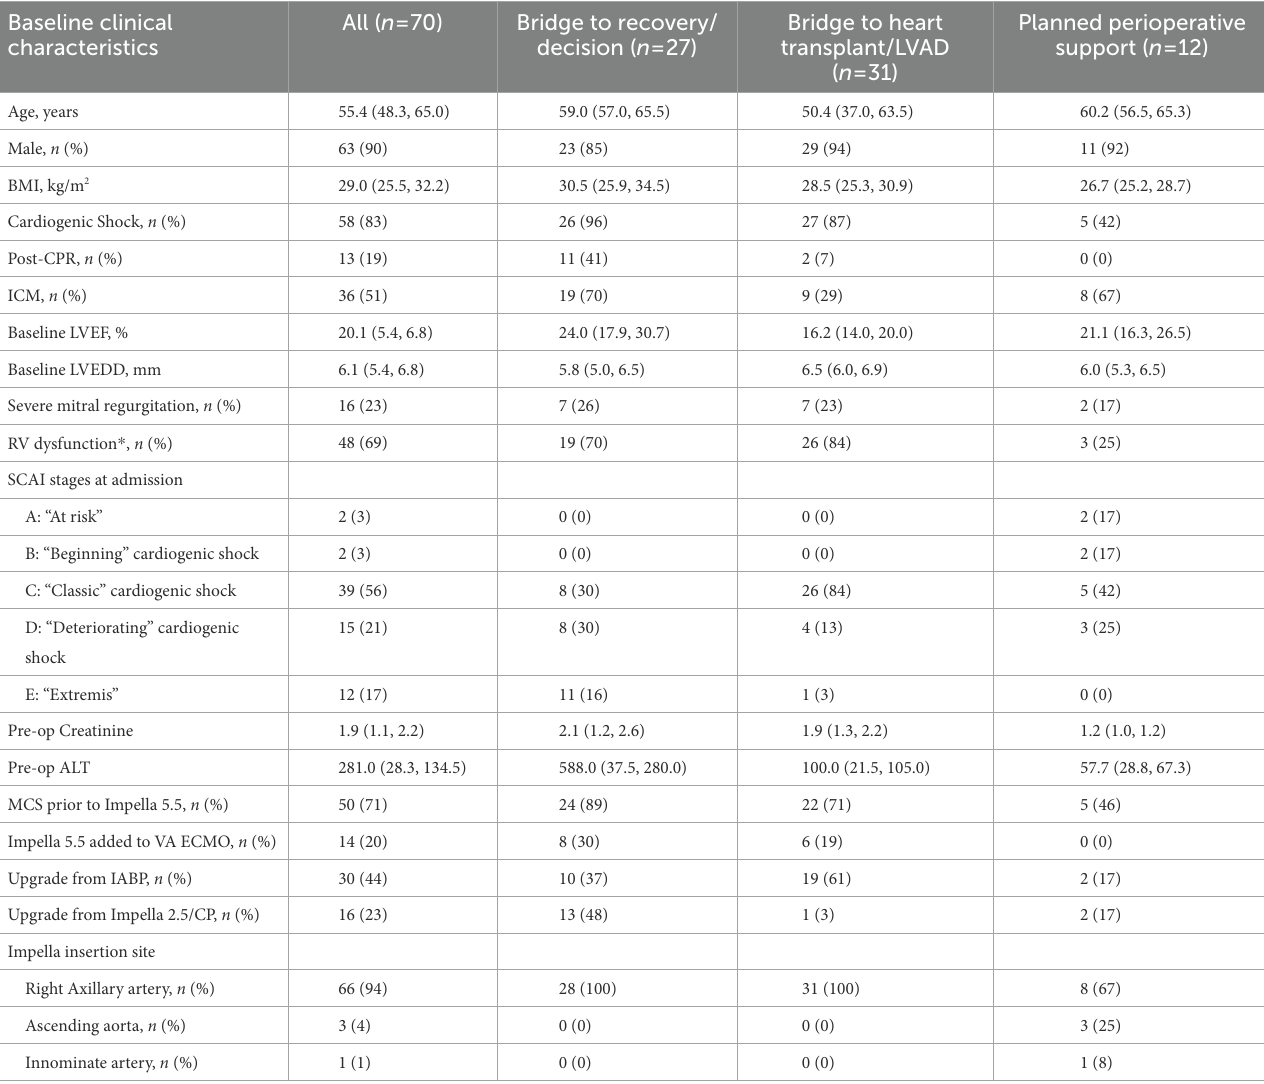
TABLE 1 Baseline characteristics and periprocedural data. Baseline clinical characteristics